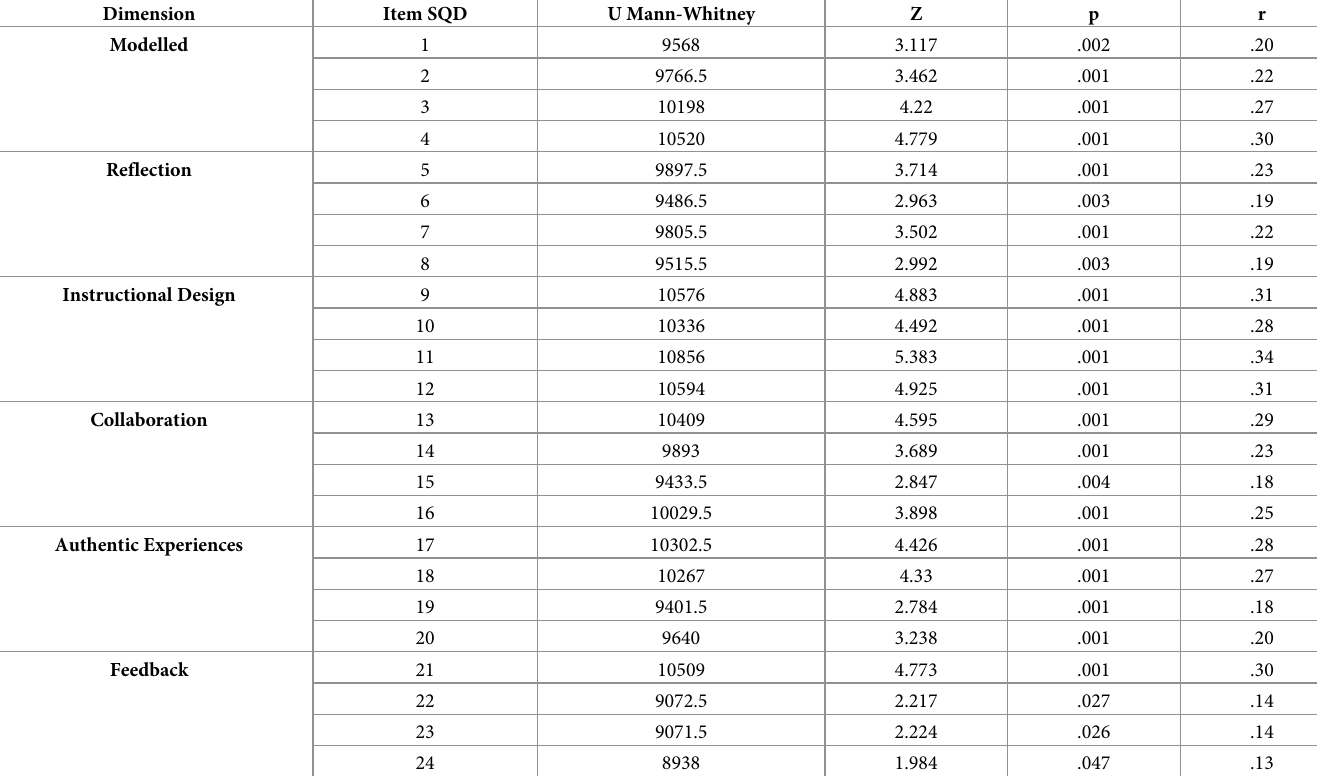
Table 4. Results of the hypothesis contrast of the variable ’Participation in ICT teaching innovation projects’ with the dimensions of the SQD. Dimension Item